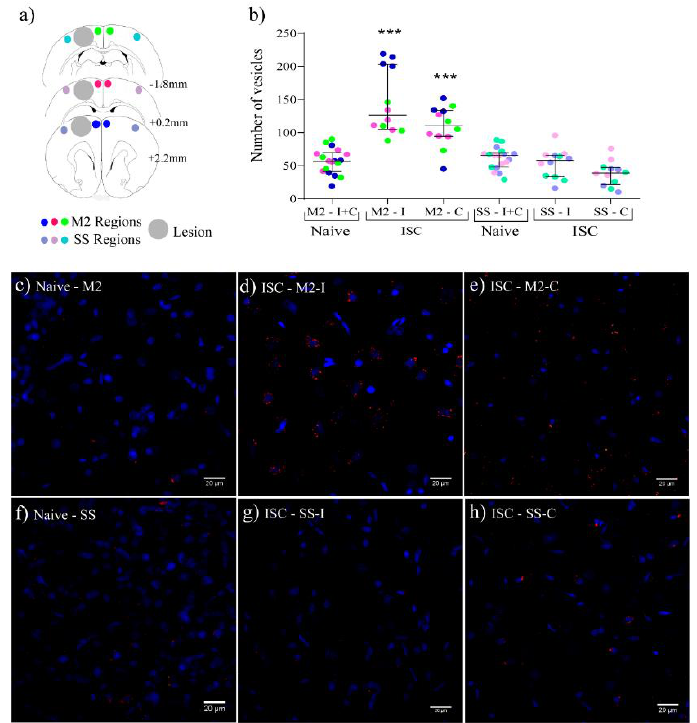
Figure 5. EV0 distribution in the brain measured 18 h after treatment. ( a ) Schema of the regions where the images were taken. Supplementary motor cortex (M2) and somatosensory (SS) (positions +2.20, 0.2, and −1.88 mm to Bregma). Big gray cycle: core; small color cycles: analyzed sub regions. ( b ) Figure indicating the number of vesicles in the 3 positions (3 different colors) of ipsi- (I)- and contra (C)-lateral M2 and SS regions. ( c – h ) representative images of the M2 and SS regions at +0.20 mm to the Bregma: ( c ) naive M2, ( d ) ISC M2-I), ( e ) ISC M2-C, ( f ) naive SS, ( g ) ISC SS-I, ( h ) ISC SS-C. Statistical analysis by Mann–Whitney test. Data are reported as median and interquartile range. *** p < 0.001 compared to all other groups without asterisks (n = 3). Scale bars = 20 µm.